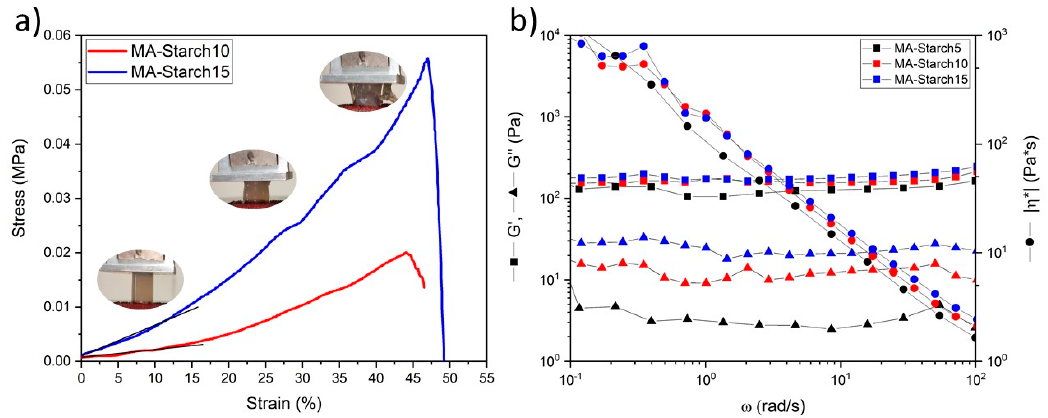
Figure 4. ( a ) Stress–strain curves of MA-Starch 10% and 15%; and ( b ) storage modulus G’, loss modulus G”, and the dynamic viscosity | η * | as a function of the applied frequency ω for the MA-Starch hydrogels.